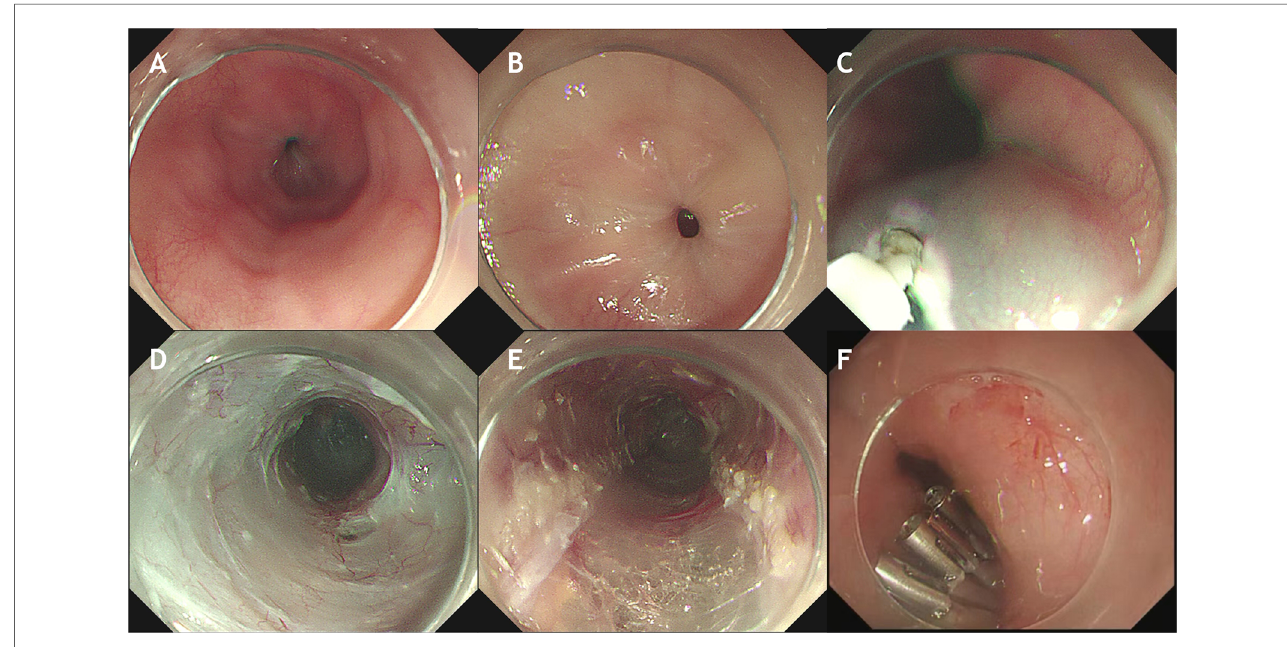
FIGURE 2 Upper gastrointestinal endoscopy and the technique of POEM in a case with acute pandysautonomia-associated distal esophageal spasm. ( A ) Endoscopic view before POEM revealing contractile ring at the lower esophagus. ( B) Closed cardiac. ( C ) A longitudinal incision is made into the upper esophagus. ( D ) A submucosal tunnel from the esophagus to the gastric cardia is created. ( E ) Full-thickness myotomy of the lower esophagus. ( F ) Closure of the mucosal incision.